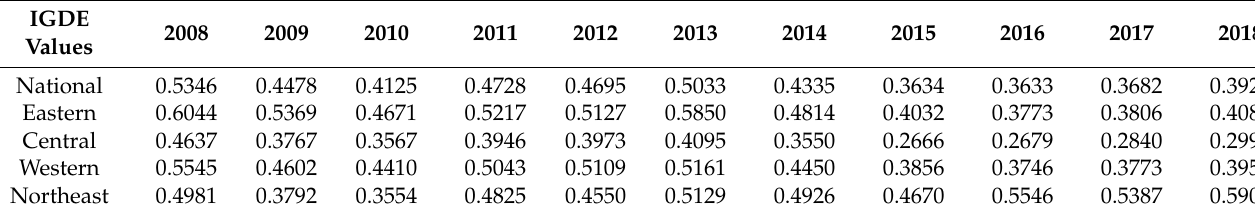
Table 2. IGDE values of China’s four regions from 2008 to 2018.